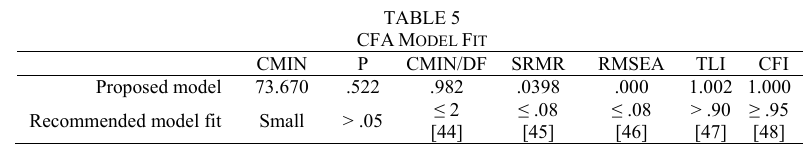
TABLE 5 CFA M ODEL F